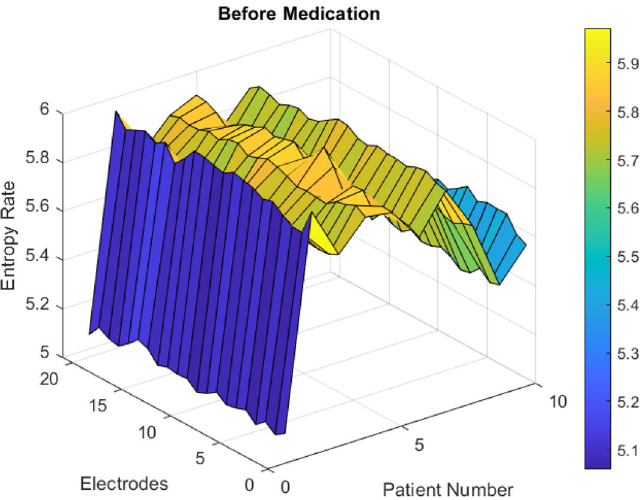
Figure 7. Before medication, Entropy Rate (∆E) is high in bipolar patients, disordered over